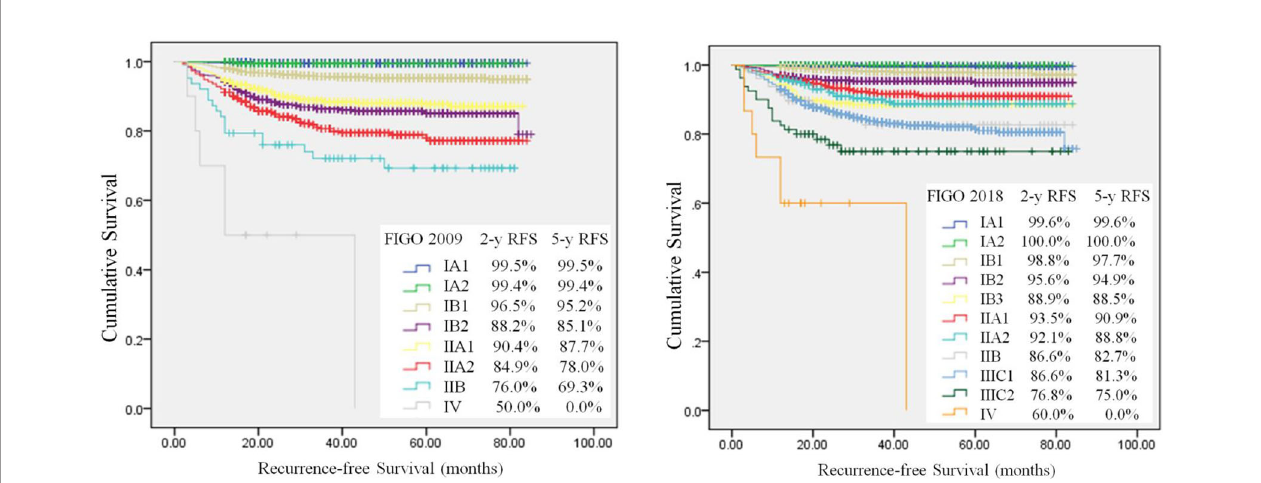
FIGURE 2 | Kaplan-Meier analysis of recurrence – free survival. Differences between use of 2009 FIGO (log-rank test, P <0.001) and 2018 FIGO (log-rank test, P < 0.001) staging systems.